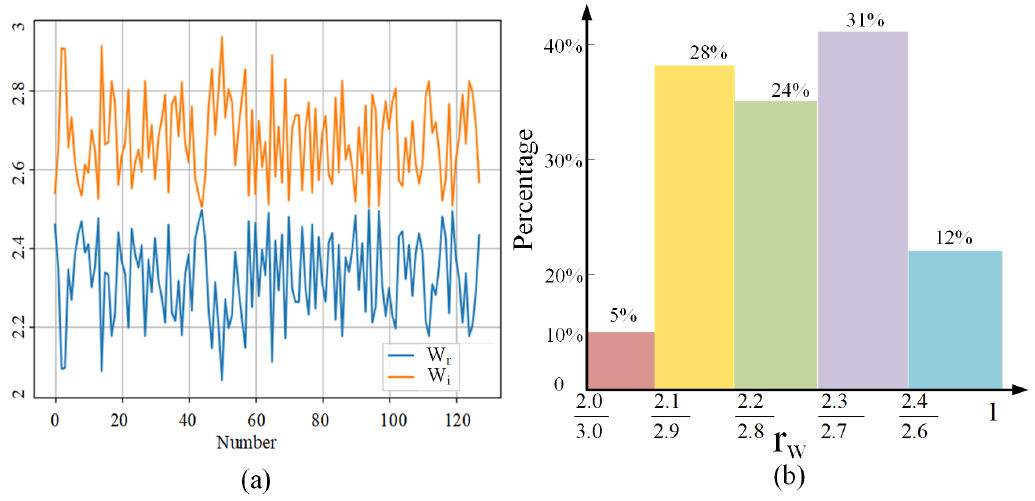
Figure 12. ( a ) Visualization of the loss weights for the person identification and activity classification tasks. ( b ) Bar chart for the statistical result of r w . It is indicated that the automatically assigned loss weights for each MD signature vary, and most r w are between Table 5. Performance comparison in F1-score for MTL with different loss weight